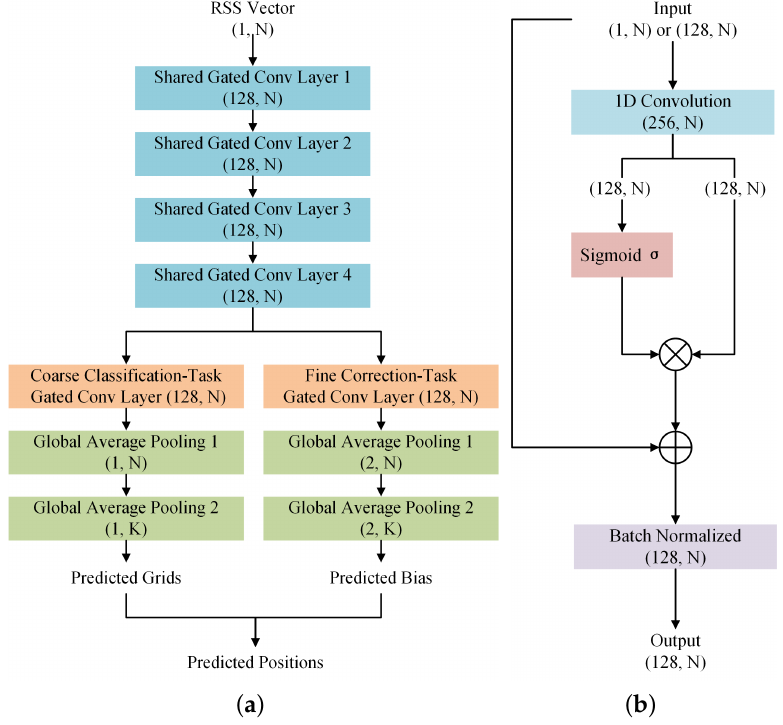
Figure 2. The architecture of ( a ) the MT-GCNN framework and ( b ) the improved gated convolu- tion